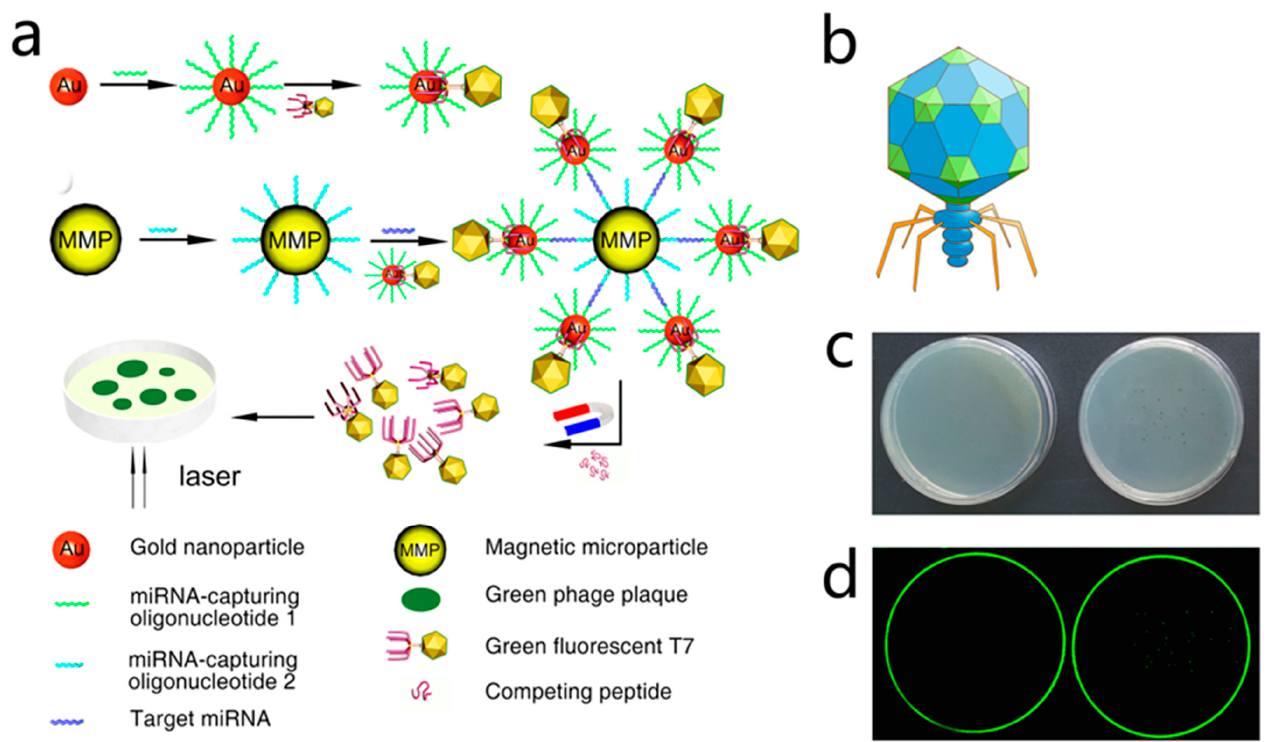
Figure 4. Phage-mediated ultra-sensitive visual detection of miRNA. ( a ) The oligonucleotides that captured miRNA were first cou- pled to GNP. This was then coupled to a fluorescent T7 phage containing a gold-binding peptide (GBP) on its tail fiber to prepare the T7-GNP probe, with specific one-to-one binding of T7-GBP to GNP. An MMP probe was prepared by binding another biotinyl- ated miRNA capture oligonucleotide to the MMP. Then the MMP probe and the T7-GNP probe were mixed with the target miRNA. GNP and MMP probes trapping the target miRNA resulted in the formation of sandwich complexes. These two different miRNA capture oligonucleotides are complementary, and thus bind to two different segments of the same miRNA target molecule (at the